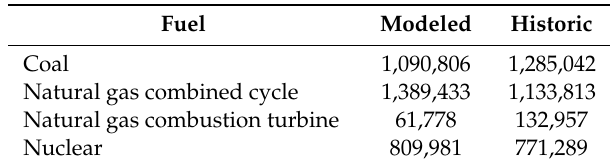
Table 2. Annual modeled electricity generation and annually-averaged historic generation (2015–2017, GWh) for U.S. by fuel type for dispatchable technologies.